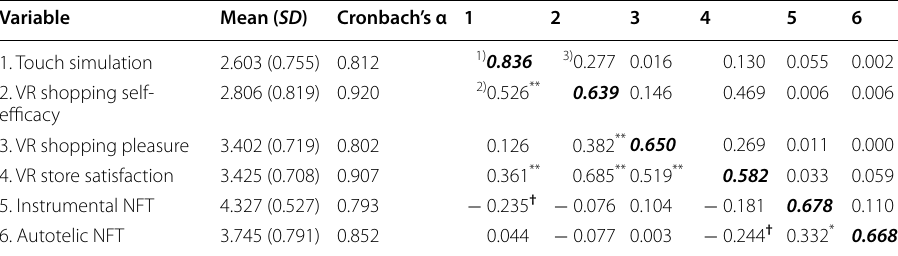
1) Numerical value of diagonal: average variance extracted (AVE), 2) Numerical value of bottom of diagonal: correlation coefficient and 3) Numerical value of top of diagonal: squared correlation coefficient ( φ 2 ) † p < 0.1, * p < 0.05, ** p <